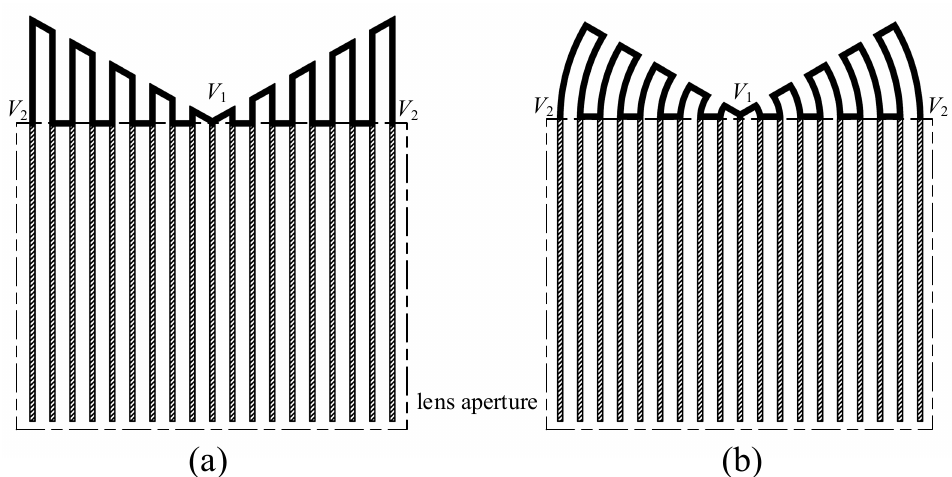
Figure 3. The electrode patterns of cylindrical LC lenses based on different generating units. ( a ) triangle type and ( b ) fan-shaped type.